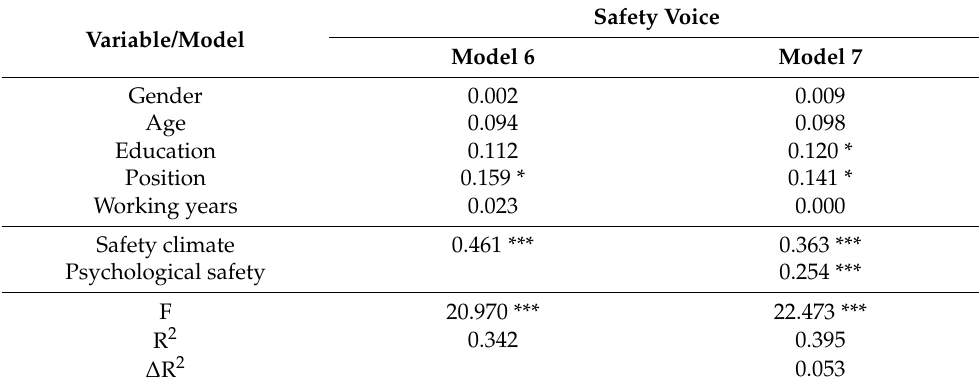
Table 5. Results of stepwise regression